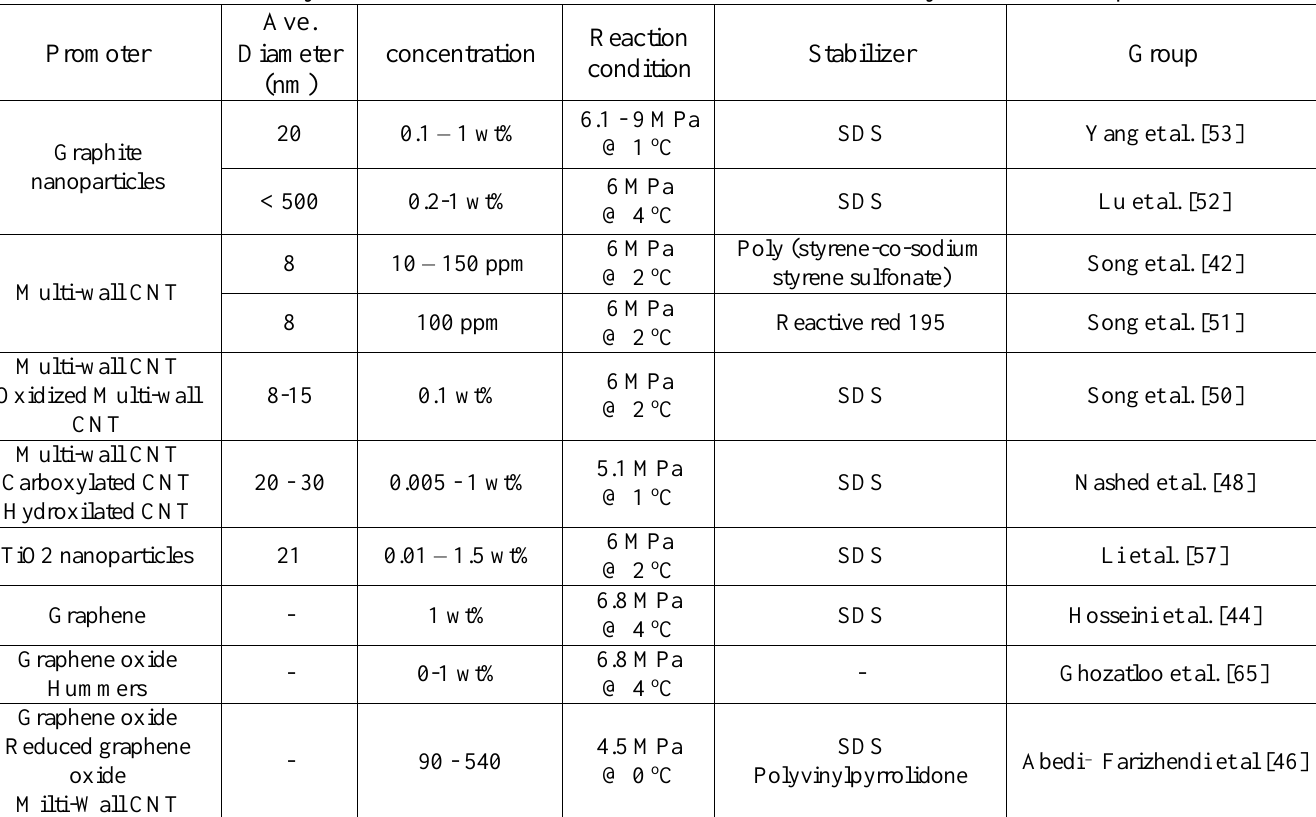
Table 1. A summary of nanostructure materials that have been used in the hydrate formation process.